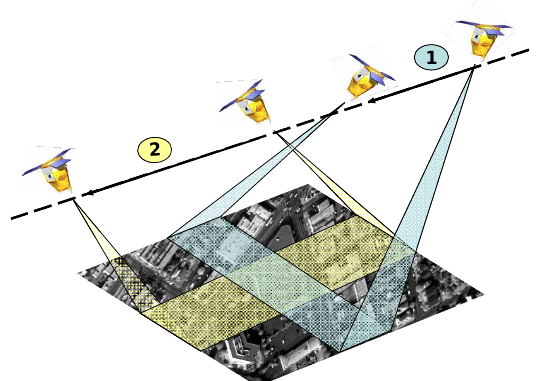
Figure 19 : maximum micro-vibrations magnitude vs CMG